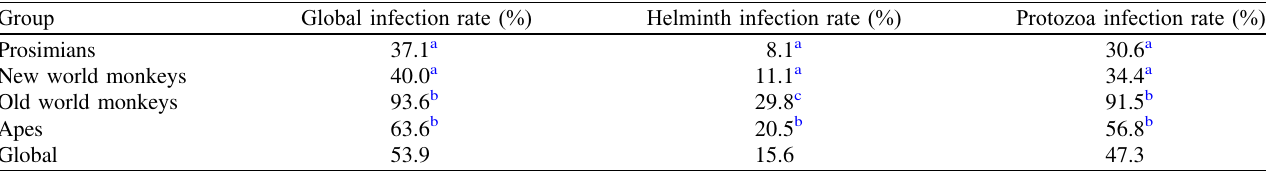
a Infection rates not signi fi cantly different between groups ( p < 0.05). b Infection rates not signi fi cantly different between groups identi fi ed with a “ b ” but signi fi cantly greater than groups identi fi ed with an “ a ” and signi fi cantly lower than those identi fi ed with a “ c ” (if applicable) ( p < 0.05). c Infection rates signi fi cantly greater than groups identi fi ed with an “ a ” or “ b ” ( p <